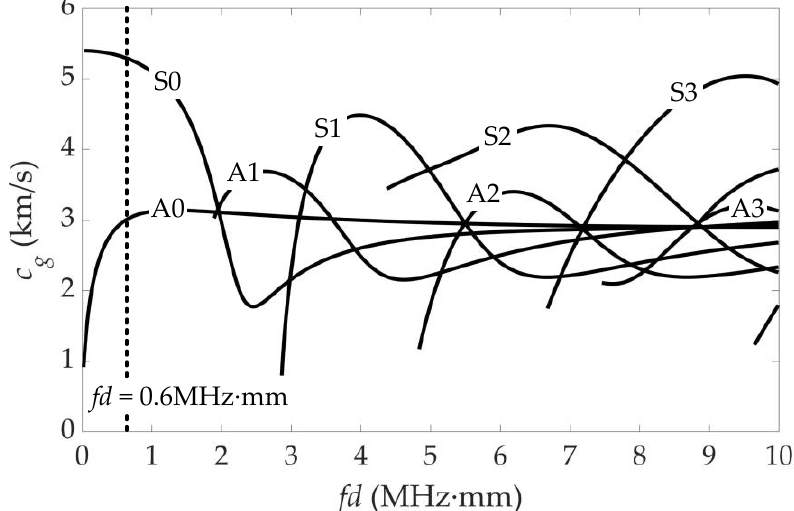
Figure 3. Group velocity dispersion curves of RL primary modes.